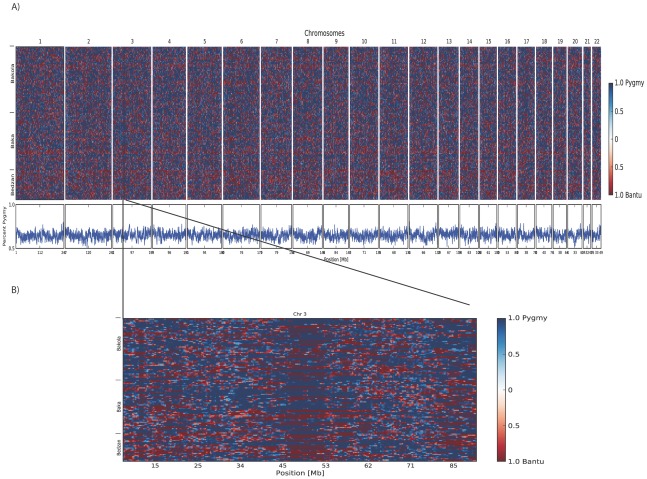
Results from local ancestry inference.A) Genome-wide blocks of Pygmy and Bantu ancestry in Pygmy individuals. B) Blocks of Pygmy and Bantu ancestry in Pygmy individuals for chromosome 3. Shades of blue represent Pygmy ancestry and shades of red admixed Bantu ancestry. Shades are determined by the posterior probability of the estimates; darker colors indicate greater confidence. Each individual is represented by two horizontal rows (one for each haploid genome) and columns represent each window in the genome. Inferred percent Pygmy ancestry for each window is given below. Using SupportMix analysis, we determined the average ancestry block sizes in Pygmies to be 1.7+/−2.4 Mb for Pygmy ancestry, and 3.1+/−4.6 Mb for Bantu ancestry.